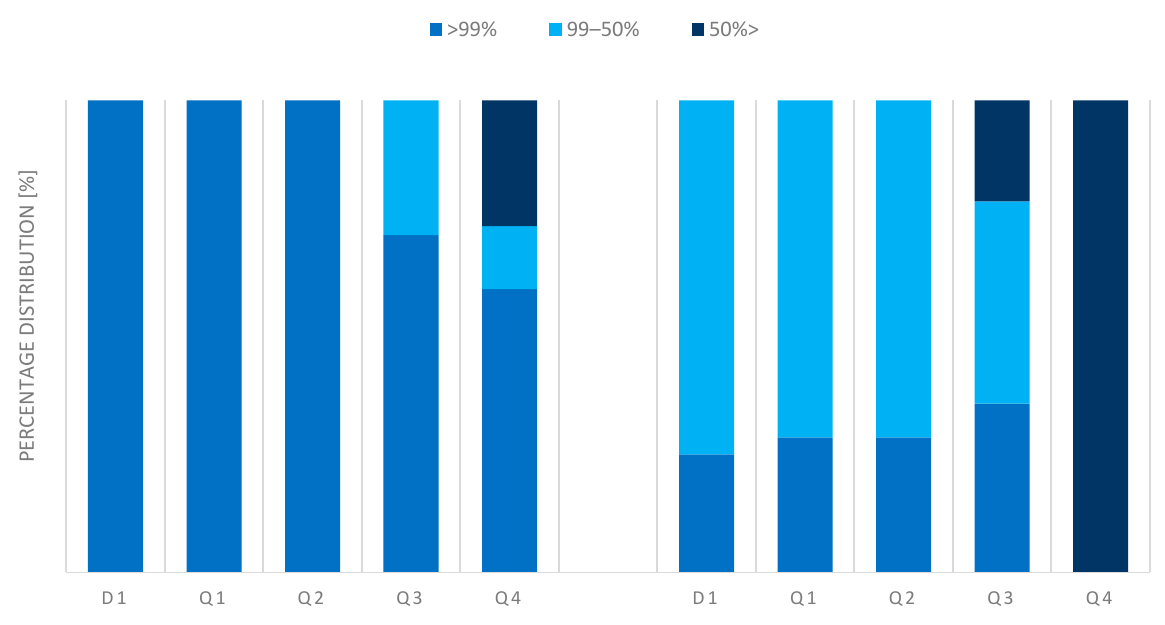
Figure 11. Catalytic performance of catalysts .